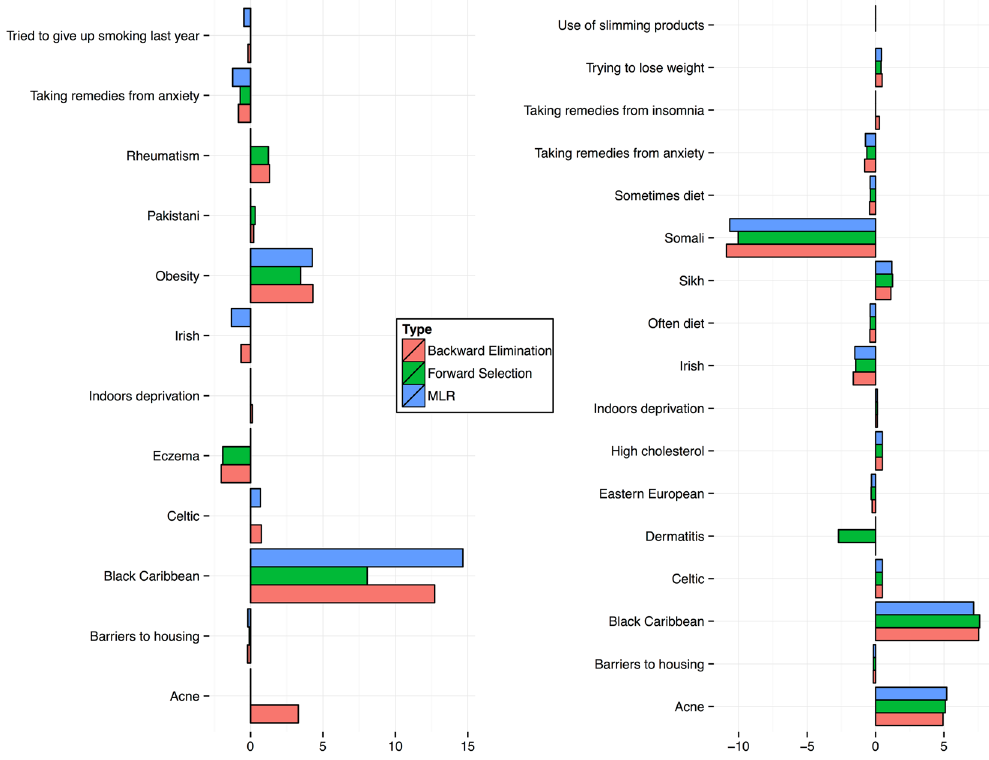
Figure 4. Candidate risk variables, constituting modeling scenarios without (left) and with (right) self- diagnosis variable. All regression coefficients presented have CI 95% and